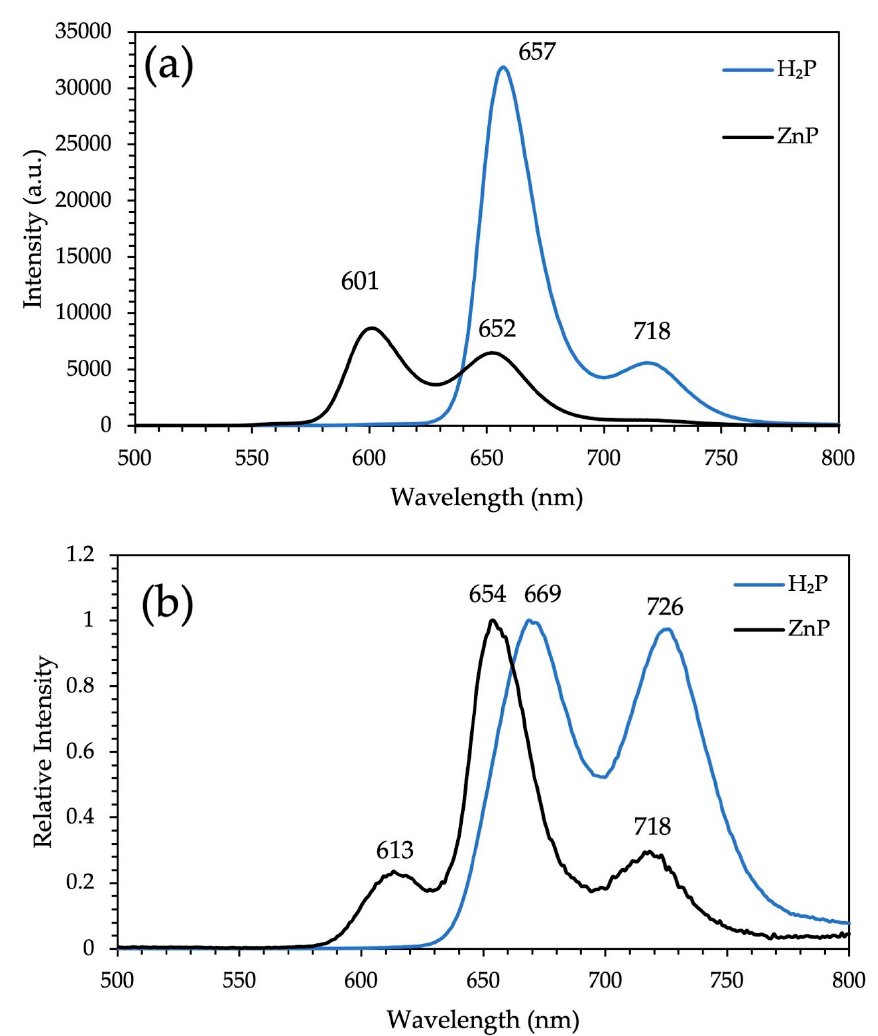
Figure 2. Photoluminescence spectra of H 2 P and ZnP excited at 421 nm in CH 2 Cl 2 at 10 − 6 M ( a ), and normalized spectra of the solid state of H 2 P and ZnP ( b ). Table 1. Absorption and emission data for compounds H 2 P, CuP, and ZnP in CH 2 Cl 2 at 298 K.